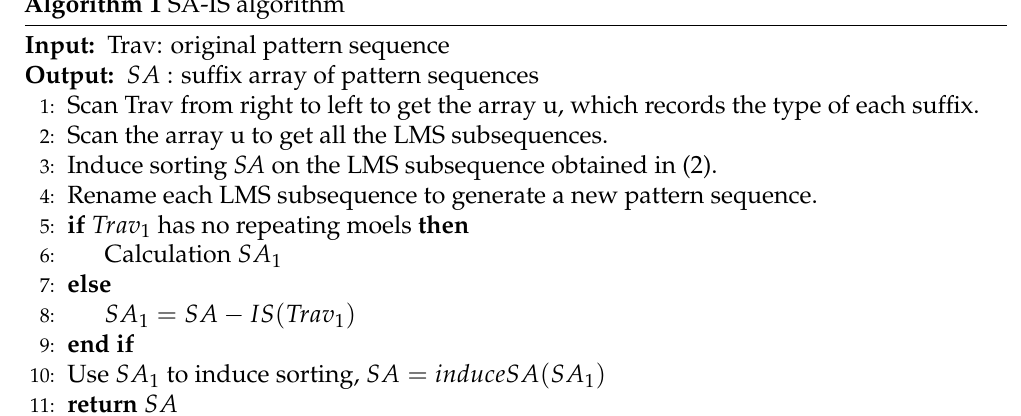
Figure 3. Similarities and differences between SA array and RK array. Algorithm 1 SA-IS